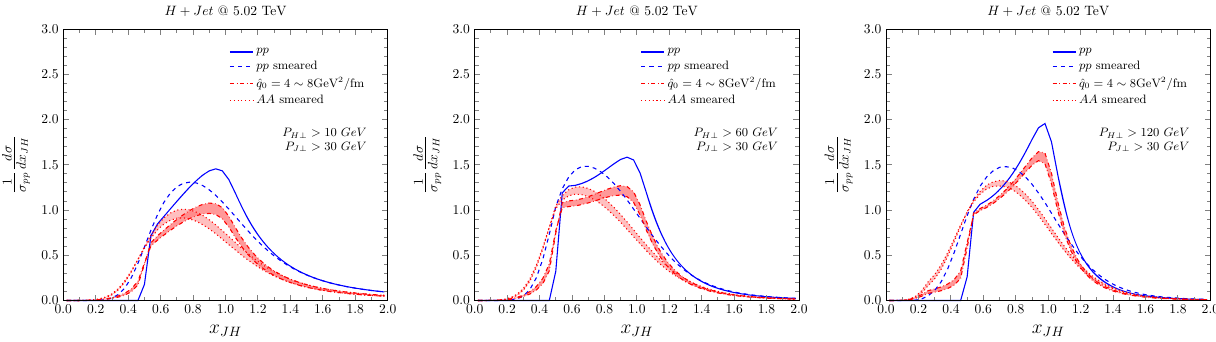
Fig. 9 A projection of the normalized x JZ distribution both smeared and unfolded for pp and PbPb collisions in the similar kinematic settings as in the Z + jet CMS [60] experiment. Panels from left to right are P Z ⊥ > 0, 60 and 120 GeV respectively. AA results are normalized to the pp cross-section